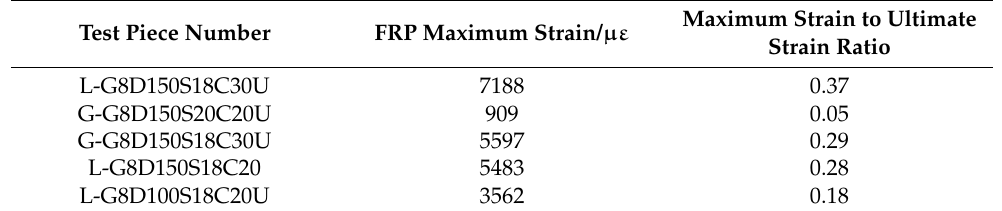
Table 8. Maximum strain summary of GFRP.